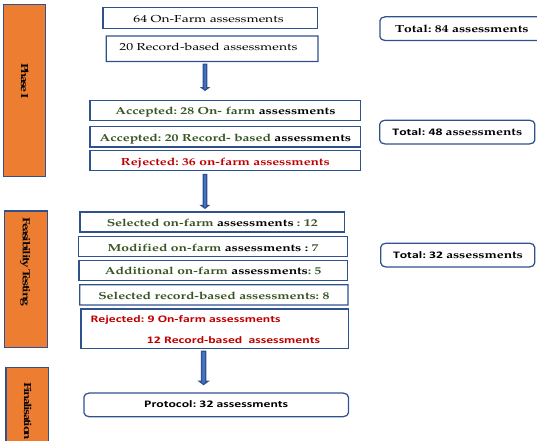
Figure 1. Summary of identification, screening, and finalisation of welfare assessments included in the protocol for assessment of welfare in pasture-based dairy cows in New Zealand.